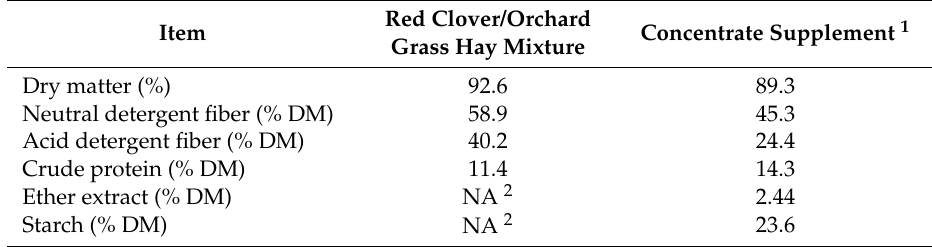
Table 1. Chemical composition of the